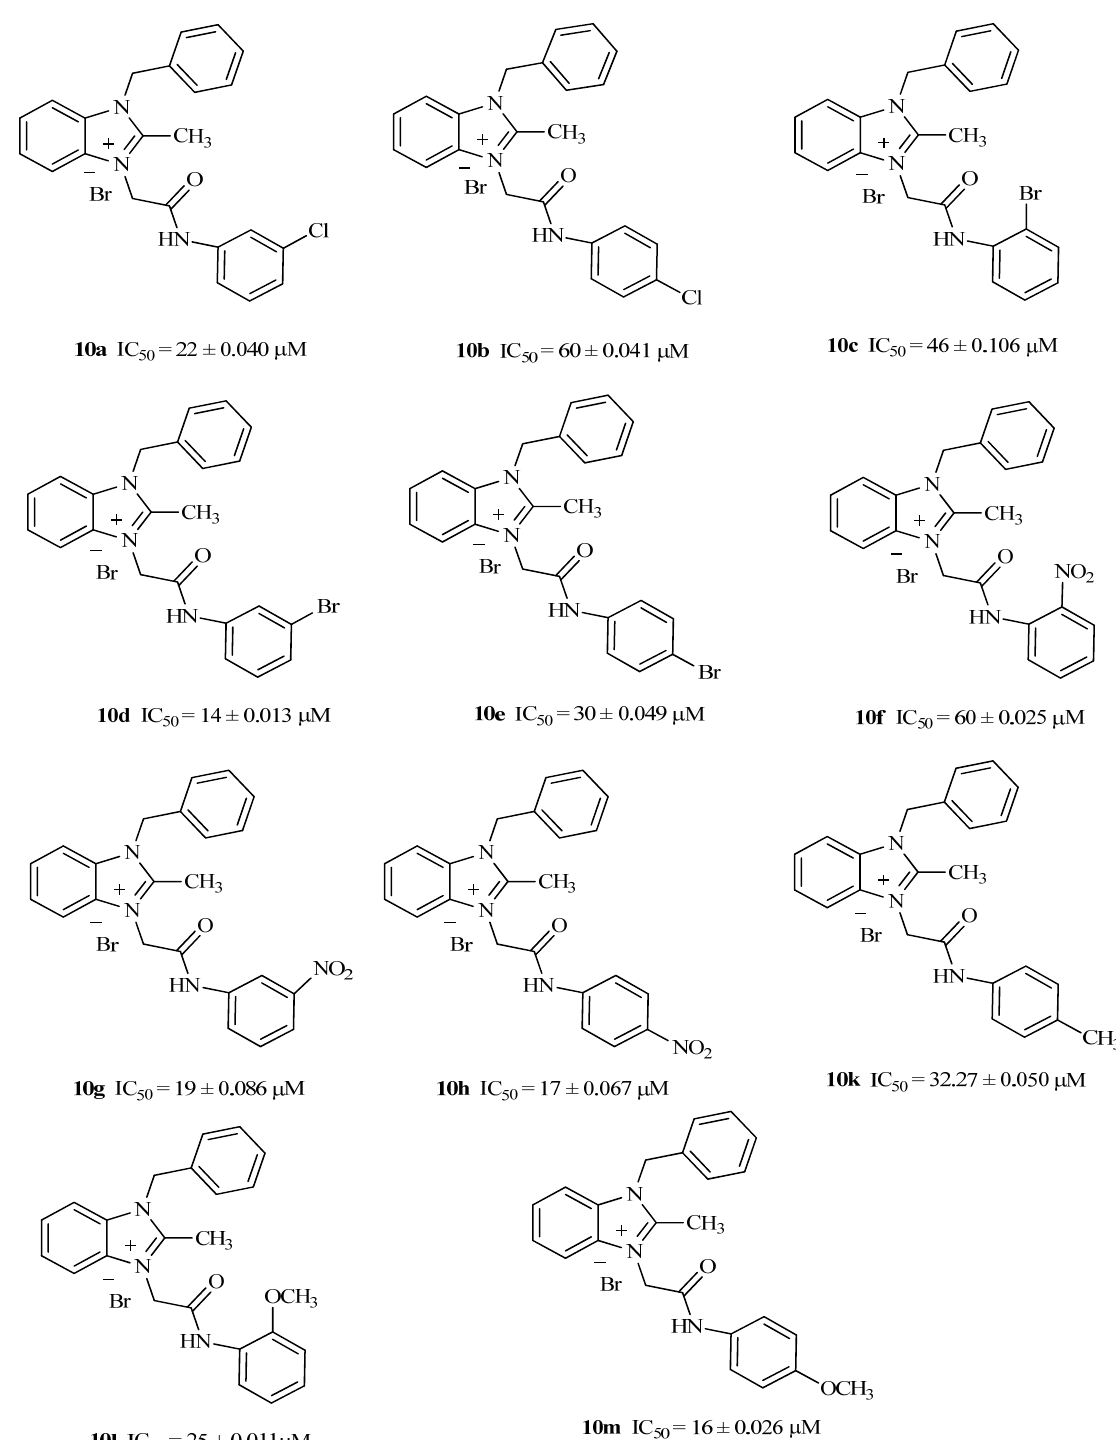
Figure 5. The chemical structures of potent α -glucosidase inhibitors.